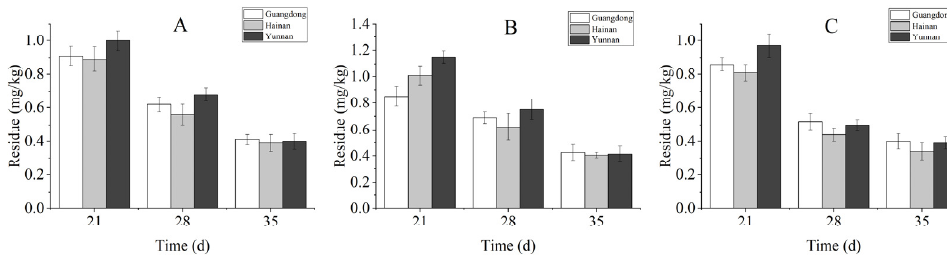
Figure 5. The terminal residues of prochloraz in a whole banana ( A ), banana peel ( B ), and pulp ( C ) from three different regions; data are presented as mean ± SE ( n = 3).